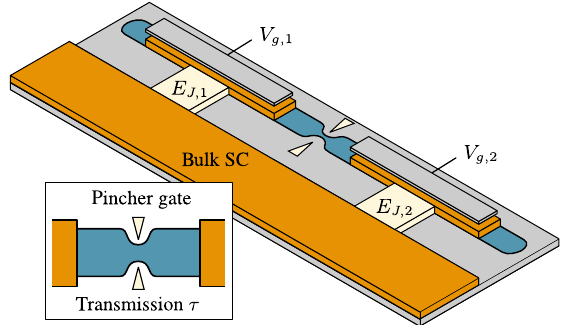
and V is g; 1 g; 2